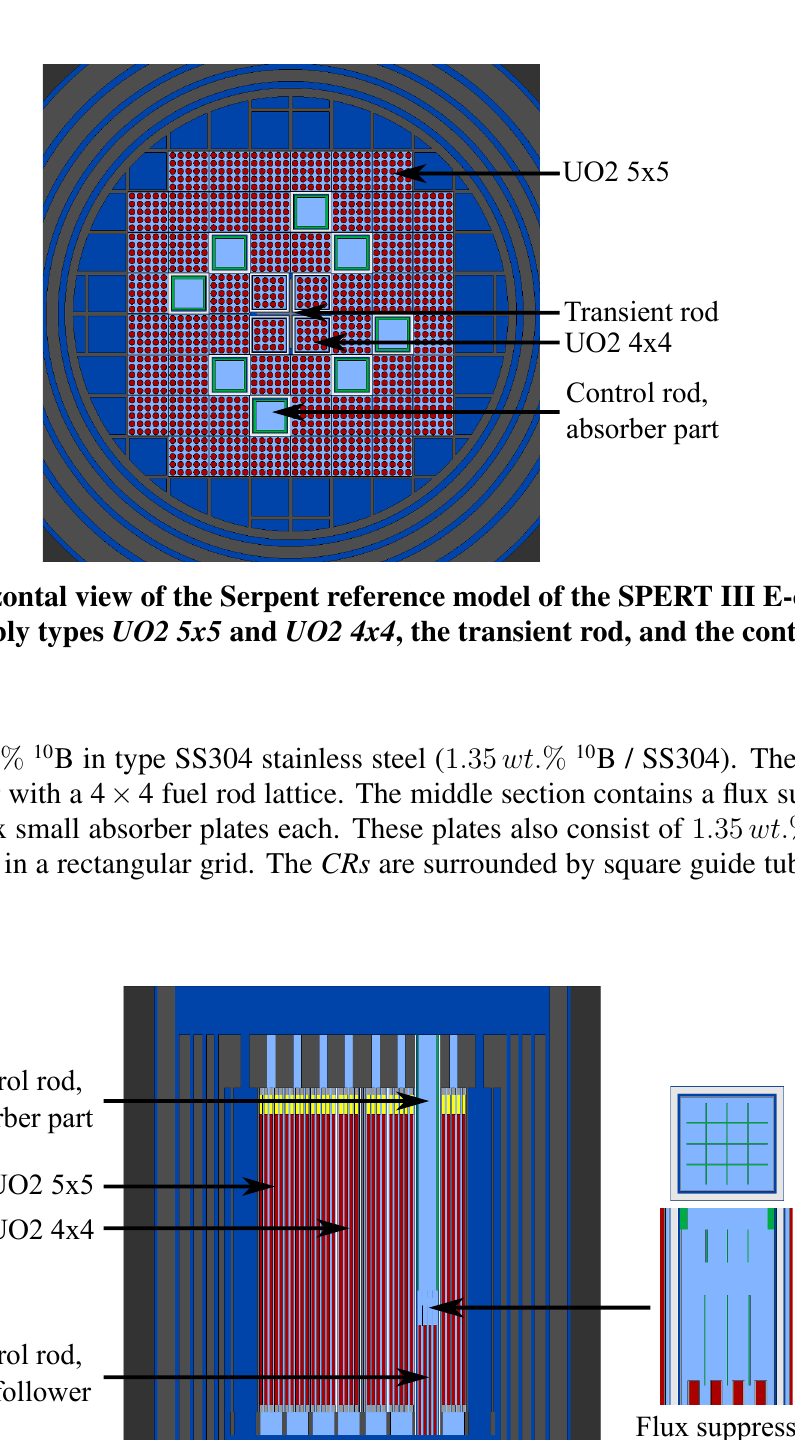
Figure 2: Left: Vertical view of the Serpent reference model of the SPERT III E-core with the fuel assembly types UO2 5x5 and UO2 4x4 , and a control rod consisting of the three sections: absorber, flux suppressor, and fuel follower. Right: Horizontal view and vertical view of a flux